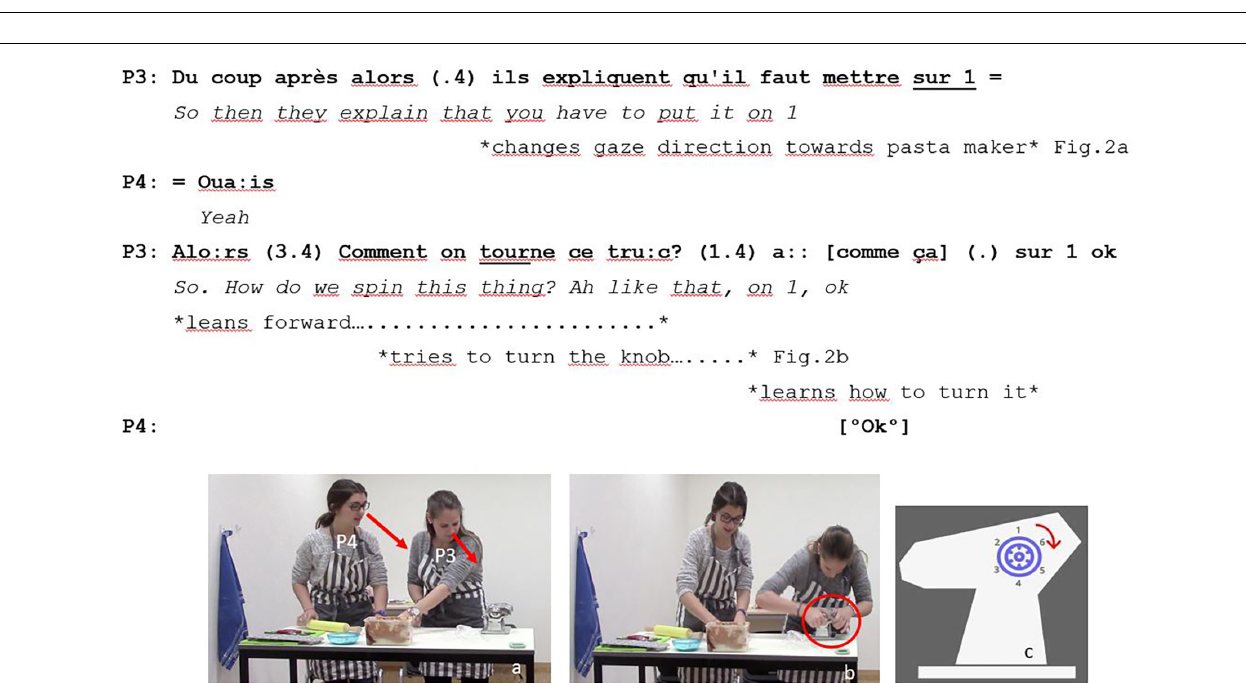
FIGURE 1 | Example of anticipation question and coordination of embodied actions.